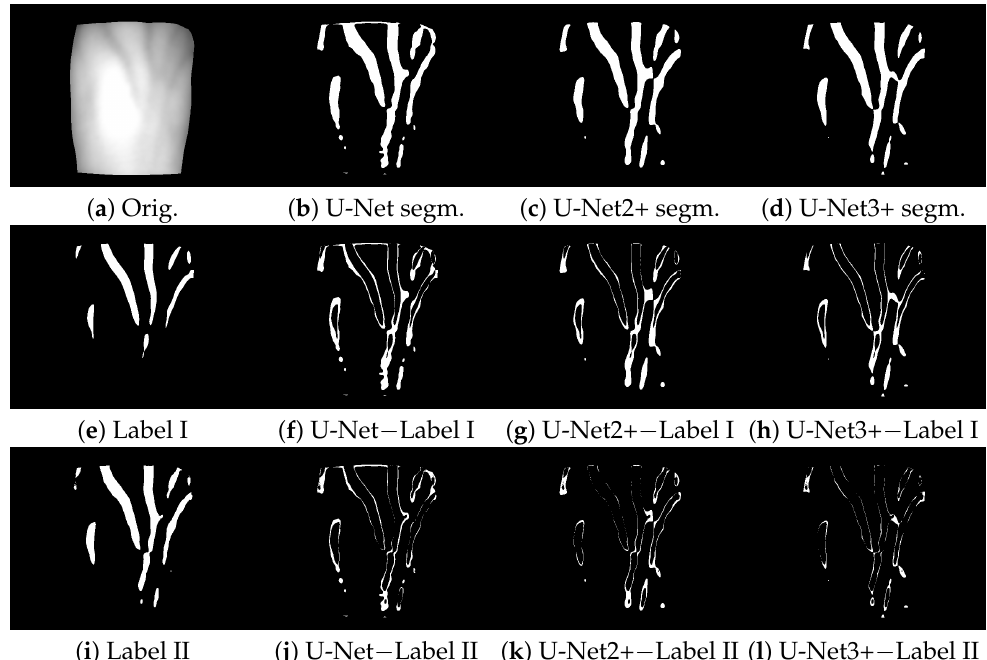
Figure 22. Visual comparison of U-Net, U-Net++ and U-Net3+ and their differences in Label I and